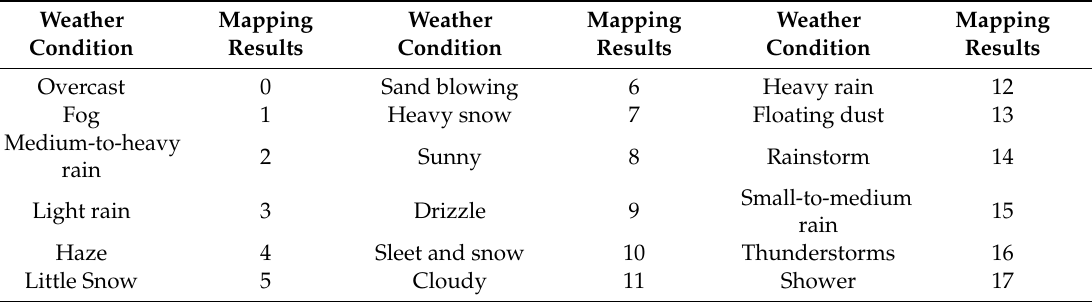
Table 2. Weather condition characteristics conversion